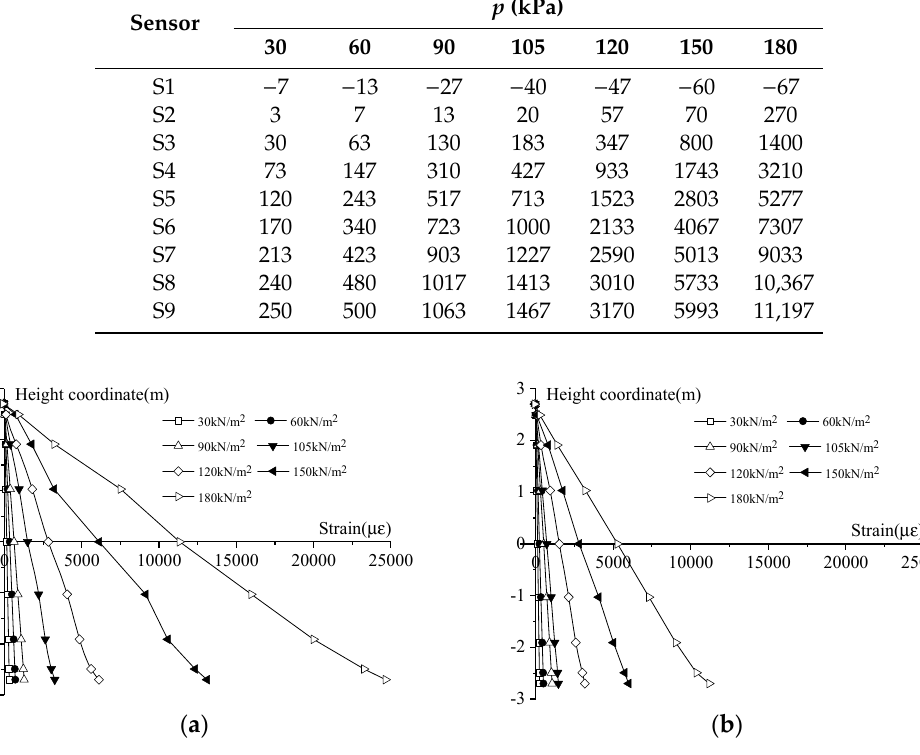
Figure 10. Deformation at different positions in the area influenced by the joint. ( a ) E9; ( b ) E6. Table 3. The values of χ , γ , and R 2 from the linear best-fitting equation at each loading step.